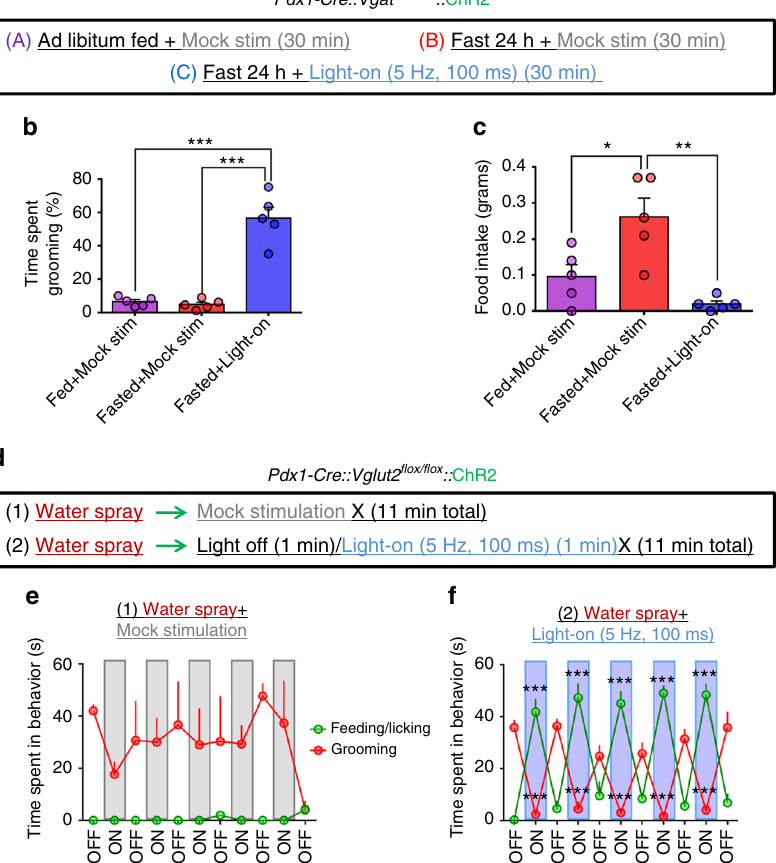
(Fig. 5h). At the same time, feeding behavior was not signi fi cantly